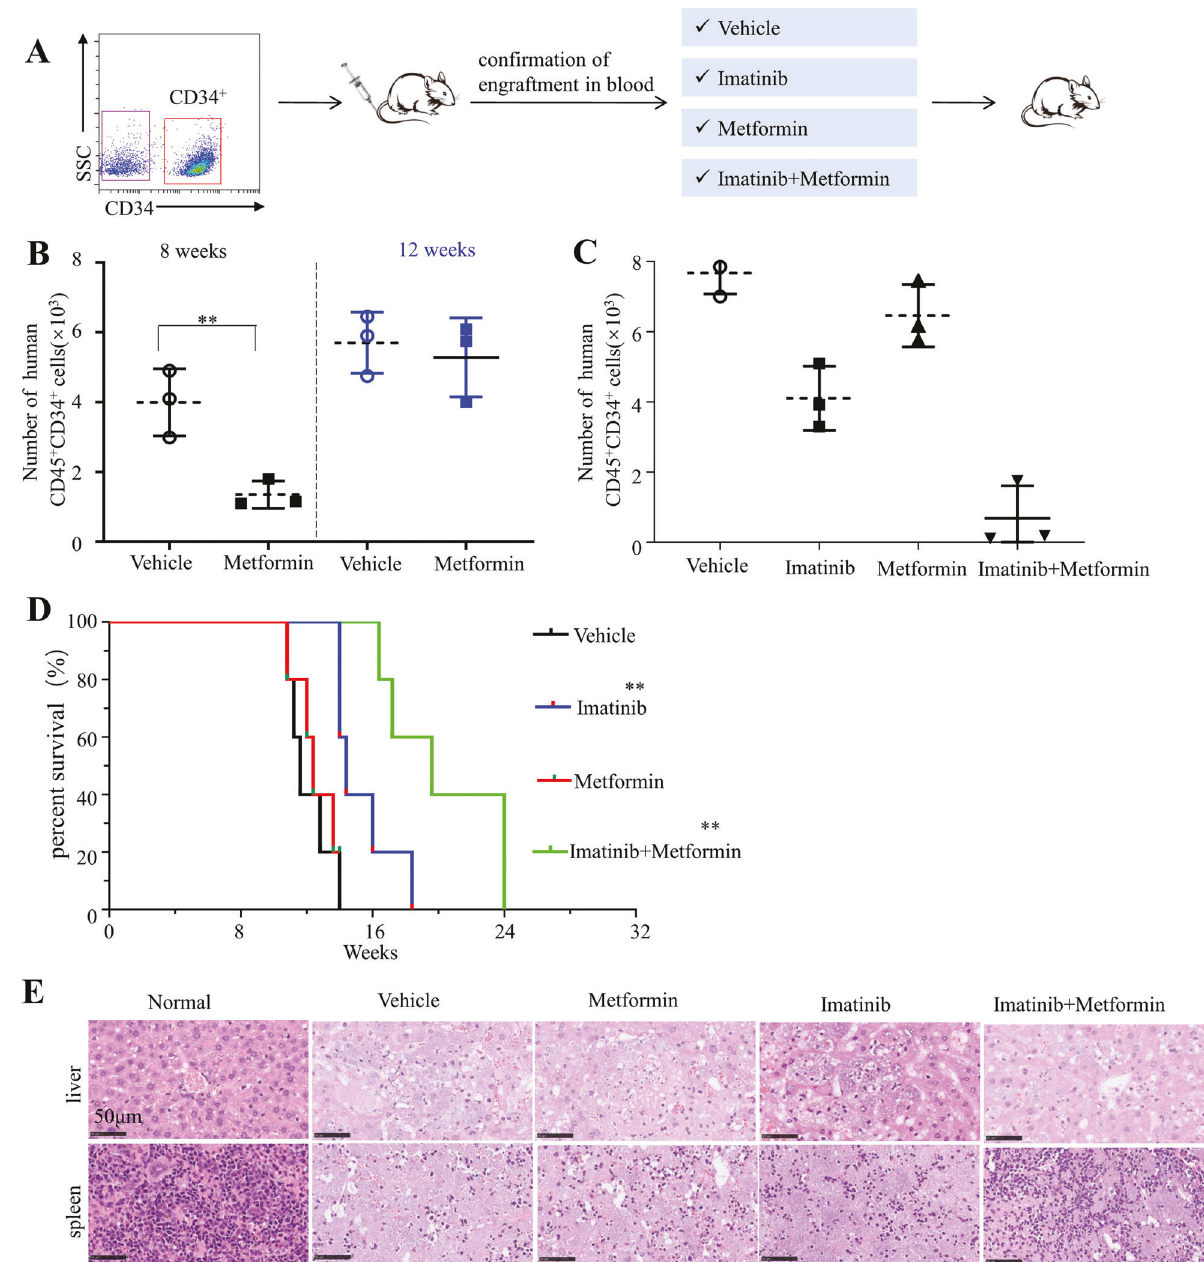
Fig. 5 Metformin resumes the sensitivity of CD34 + CML cells to imatinib in the PDX model. A Diagram of experimental design. The engraftment of CML CD34 + cells in mice were assessed by monitoring the percentage of human CD45 + circulating leukocytes using fl ow cytometry. B , C Percentages of human CD45 + CD34 + cells in the bone marrow post transplantation are shown. D Survival of the CML PDX mice with indicated treatment was shown. E The leukemic invasions in the spleen and liver of PDX mice with indicated treatment were analyzed by hematoxylin and eosin (H&E)